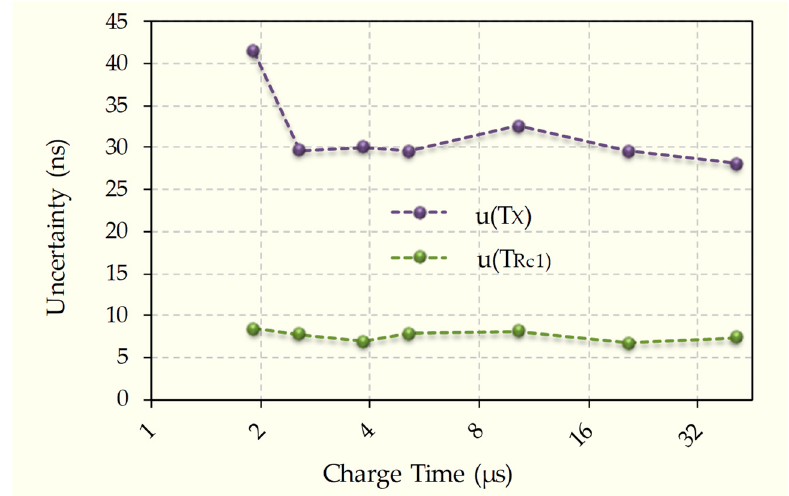
Figure 6. Comparison of uncertainties in discharge times measured in the capacitor node and in node X when discharge occurs through R C1 . Uncertainty in the capacitor node in Figure 3, u(T Rc1 ) , is shown in green, while uncertainty in the X node, u(T X ) , is shown in purple, both for different charge times (in log2 scale).